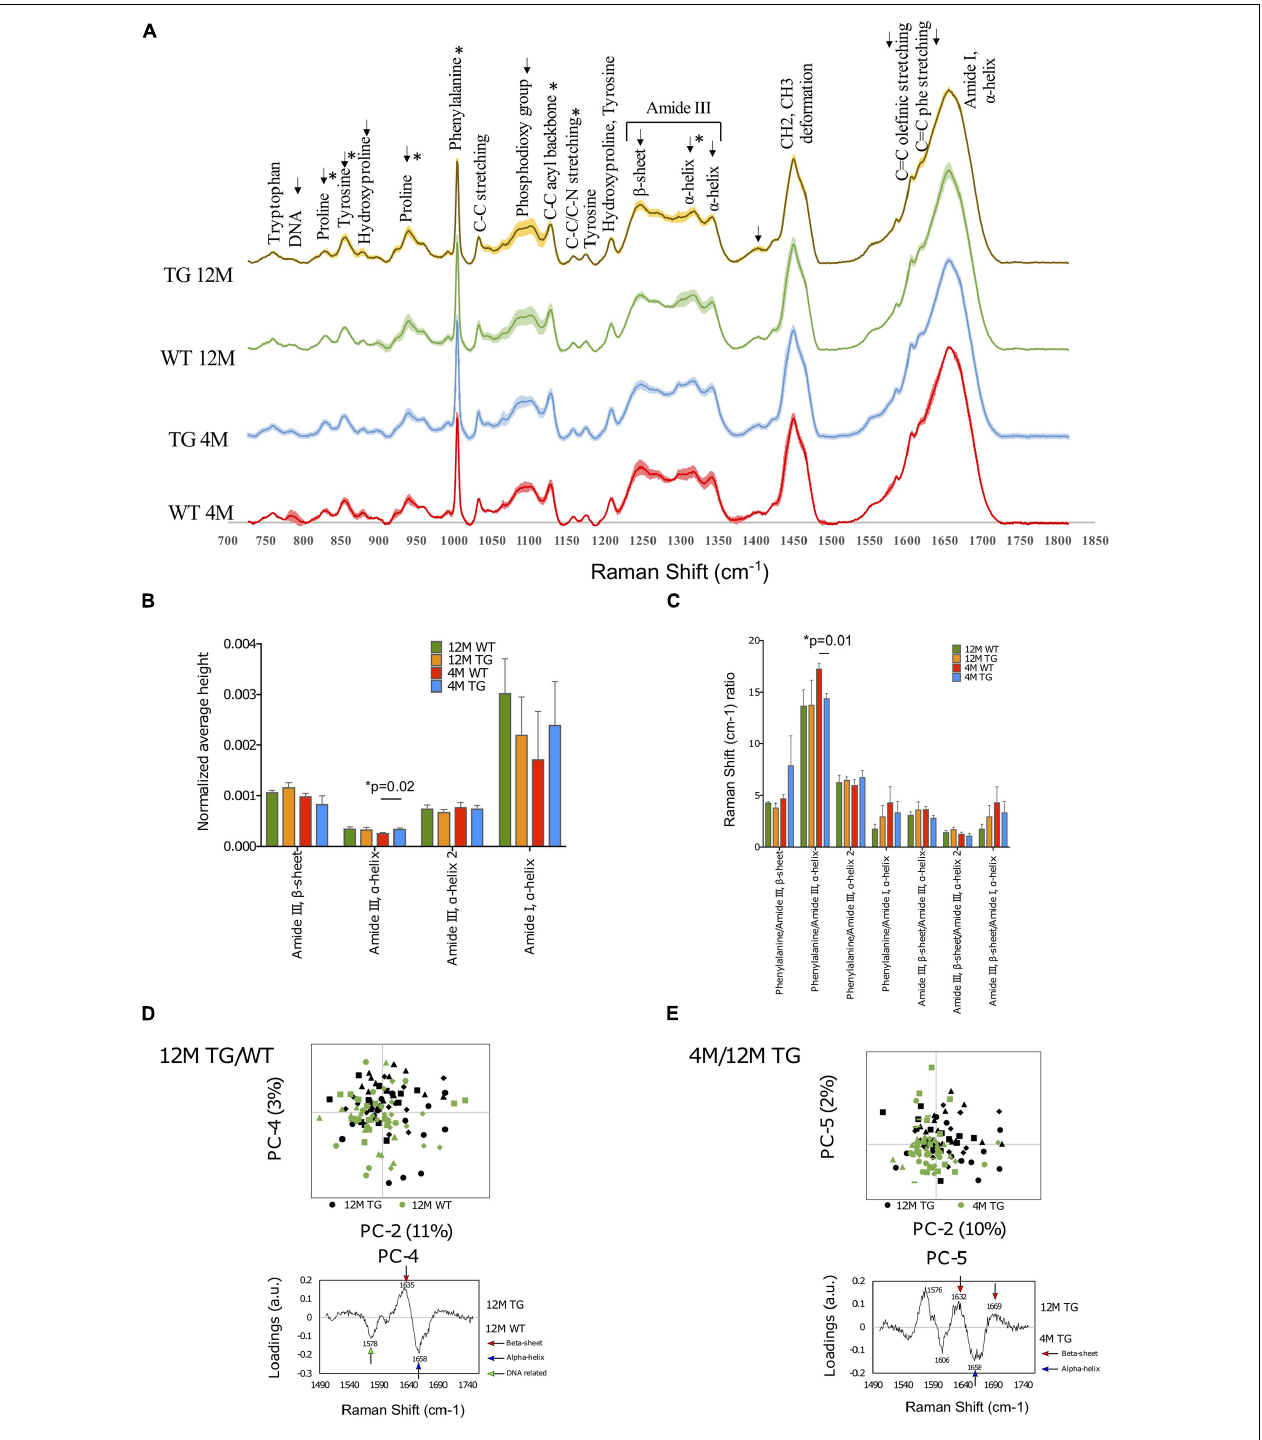
FIGURE 4 | Spectral comparison at the genotype and age of the WT and TG rat colons. (A) The spectra of WT and TG colon samples at 4M and 12M age and shaded areas indicate the standard deviation. (B) Differences were detected at the intensity at 4M age for WT and TG in the amide III, α -helix ( p = 0.01) peak. (C) The ratio of different peaks from amide I and amide III were compared with Student’s unpaired t -test to identify statistical changes. Differences were detected in the phenylalanine/amide III– α -helix ratio ( p = 0.01). p -Value represents * p ≤ 0.05. (D) Comparison of the amide I 12M TG vs. WT samples through PCA with scores and loadings in colon. Amide I samples were compared with PCA at PC-2 and PC-4 (upper panel). PC-4 was significant ( p = 0.01). The loadings of amide I PC-4 were visualized (lower panel). (E) Comparison of the amide I between 4M and 12M TG samples through PCA with scores and loadings in colon. Both PC-2 ( p = 0.00003) and PC-5 ( p = 0.004) were significant (upper panel). The loadings of amide I, PC-5 were visualized (lower panel).